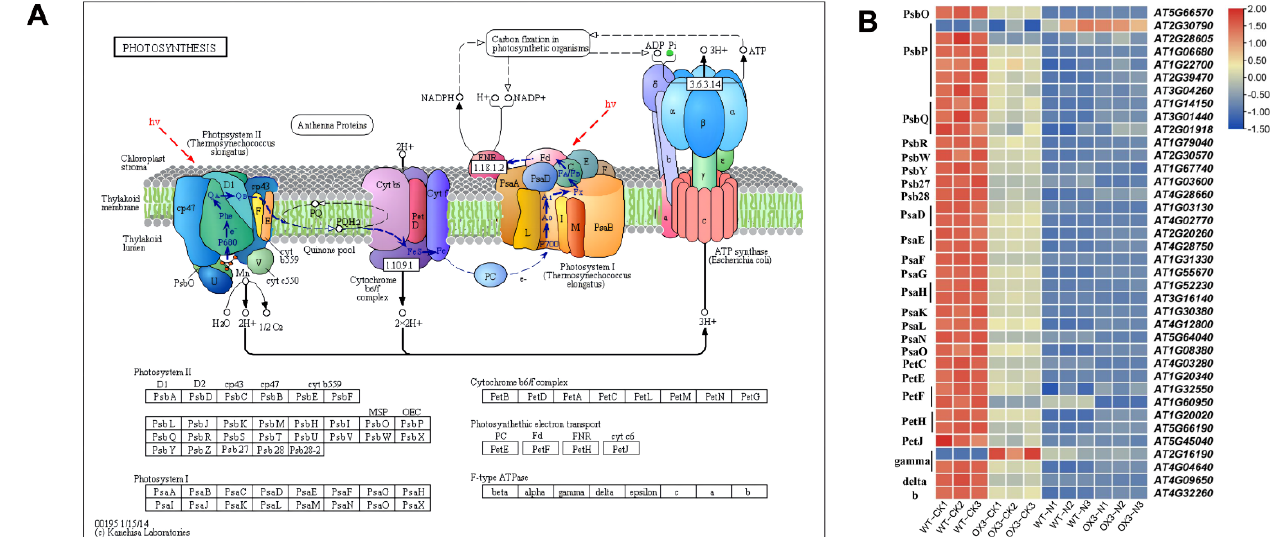
Figure 8. Transcript abundance changes of photosynthesis pathway-related DEGs in Arabidopsis wild-type (WT) and transgenic plant (OX3) under NaCl treatment. ( A ) Photosynthesis pathway (ko00195). Different letters indicated the different subunits of photosynthetic complexes. ( B ) Heat map of DEGs in photosynthesis pathway. The log2-transformed FPKM values of DEGs were used to generate the diagram.